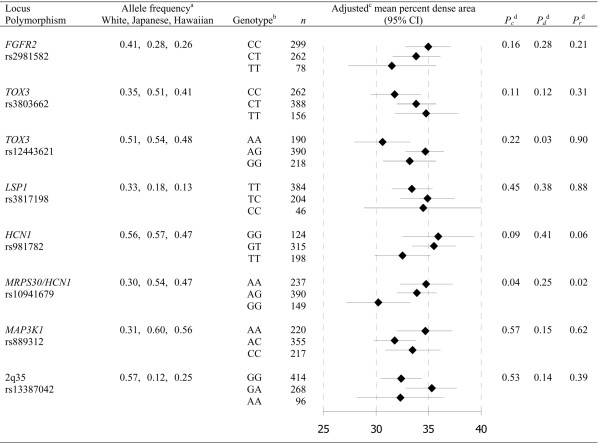
Adjusted mean percent dense area by genotype. aFrequency of the breast cancer risk allele. bIn order of increasing breast cancer risk observed in previous studies [8,9,16]. cAdjusted for age, age squared and body mass index at mammogram and ethnicity. Numeric data are shown in Additional data file 1. dPc, co-dominant P value for the per-allele increase in percent dense area; Pd, dominant P value for an increase in percent dense area with any risk allele; Pr, recessive P value for an increase in percent dense area with both risk alleles. CI, confidence interval.